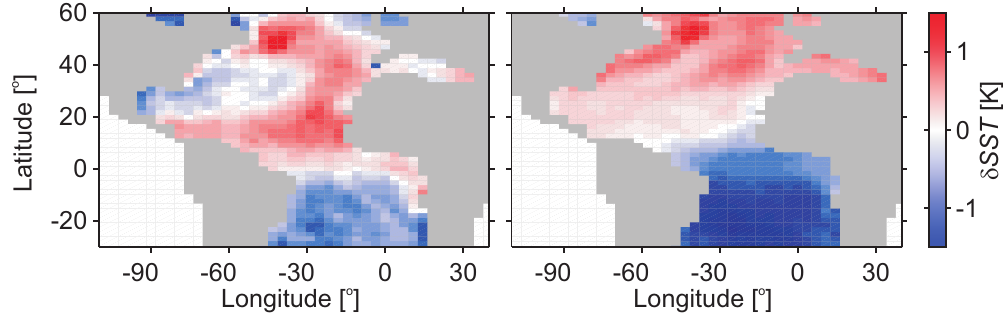
Fig. 3. (Left) Anomalous SST pattern associated with the AMO component of the instrumental record. The temperature anomalies during a negative phase of the AMO were subtracted from those of a positive phase to yield the difference map, δ SST. (Right) Anomalous SST pattern obtained from the difference of positive and negative AMO phases in the UVic ESCM.